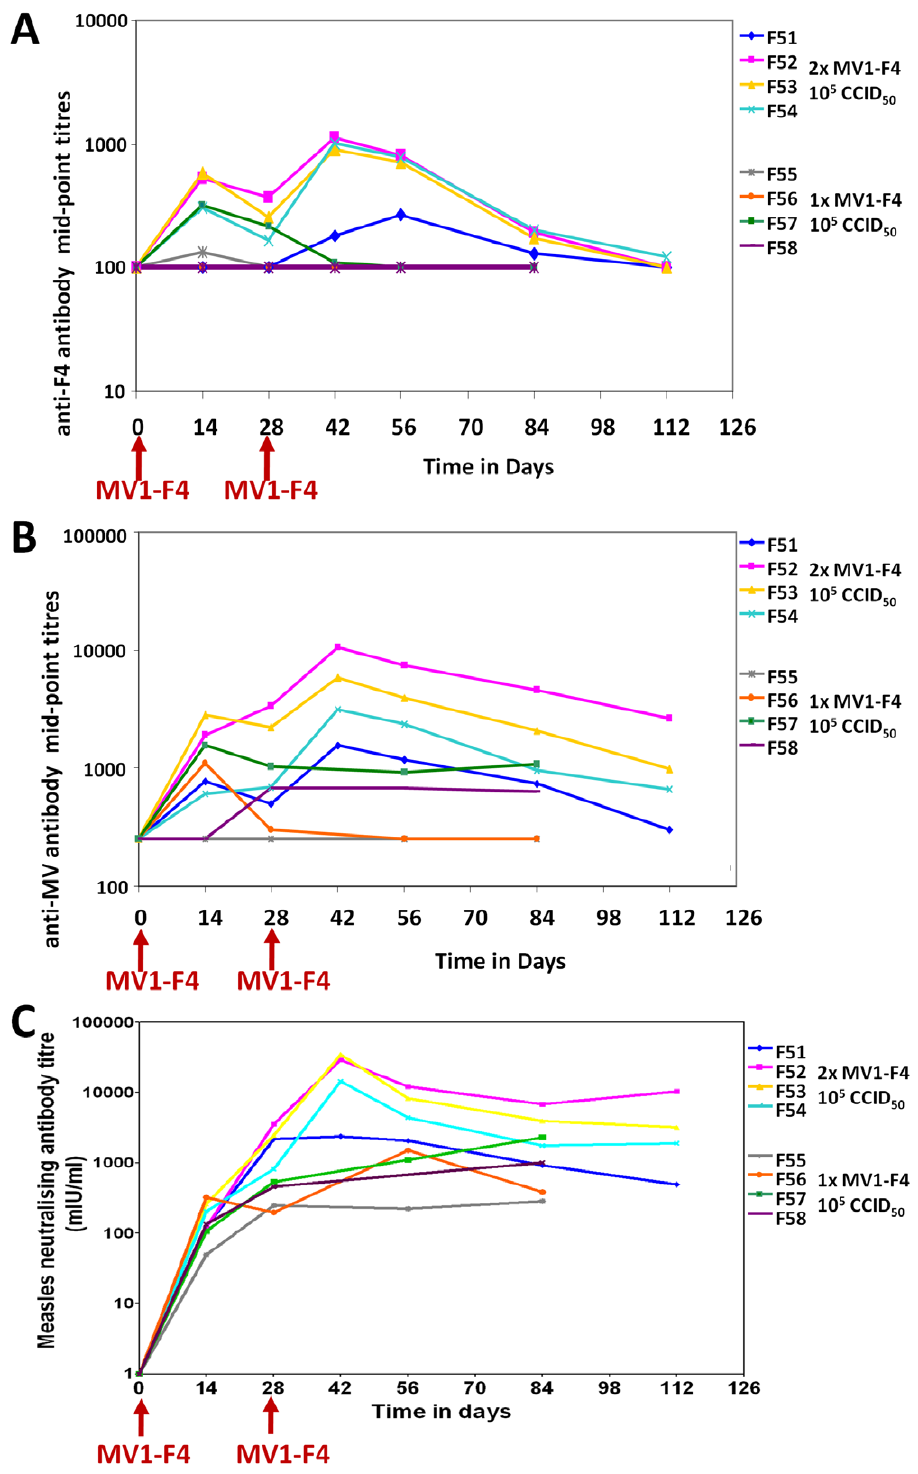
Figure 5. Macaque antibody responses to MV and F4. Anti-F4 (A) and anti-MV (B) antibody responses measured by ELISA with results given as mid-point titres, at which 50% maximal binding is achieved. Measles neutralising antibody titres (C) measured by plaque reduction assay with potency in mIU/ml calculated by direct comparison with the titre of 3rd International Standard for anti-measles serum (97/648). All vaccinees, F51– F58, were immunised with MV1-F4 on day 0, but only F51–F54 received a second immunisation on day 28 (red arrows).